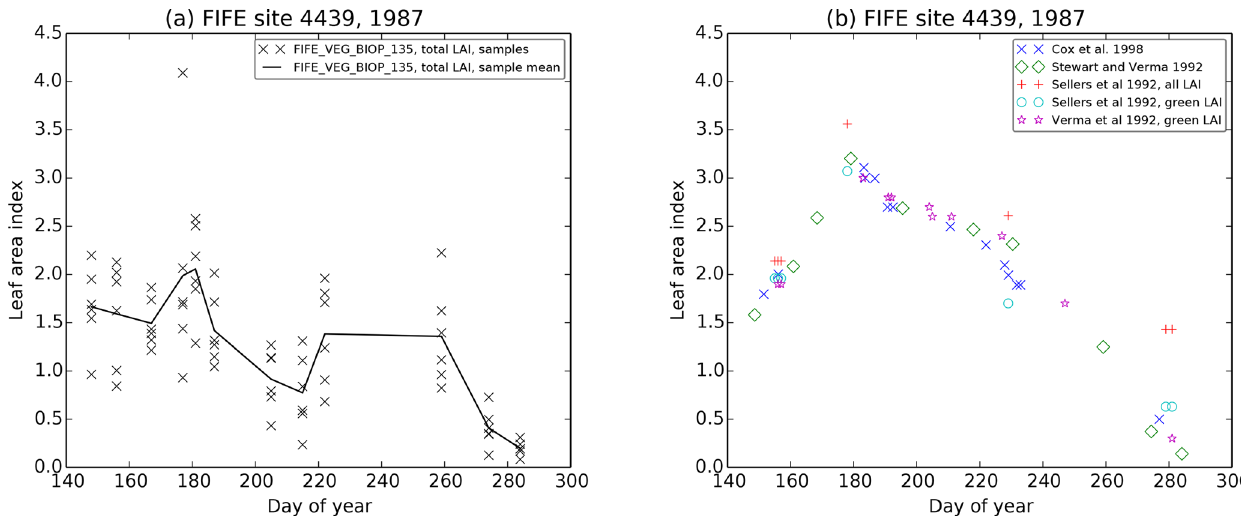
Figure A1. Leaf area index observations for site 4439 for 1987. (a) Data from FIFE_VEG_BIOP_135. (b) Literature values. Plot includes data extracted from Stewart and Verma (1992) Fig. 1 and Cox et al. (1998) Fig. 1, total LAI and green LAI from Sellers et al. (1992) for the intensive field campaigns and green LAI data from Table 4 in Verma et al. (1992).